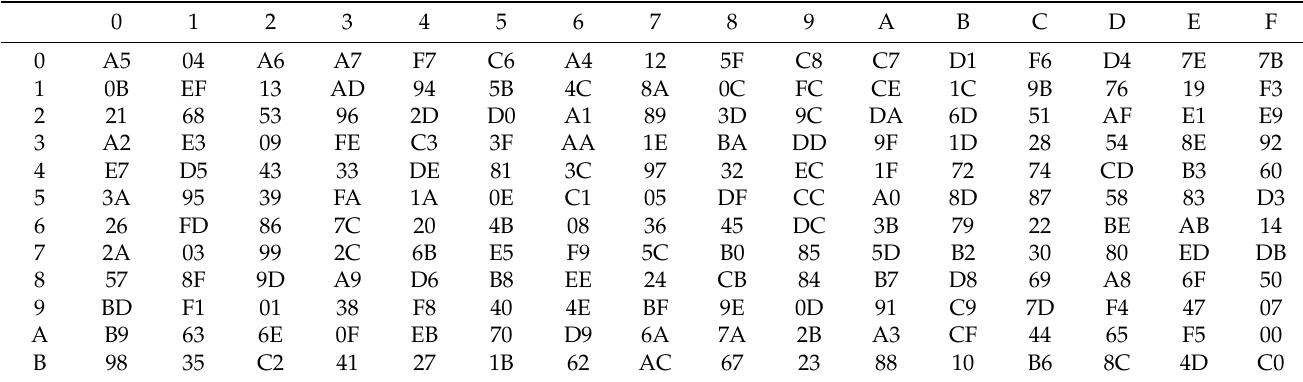
Table 1. Substitution S -box of the AL02 encryption